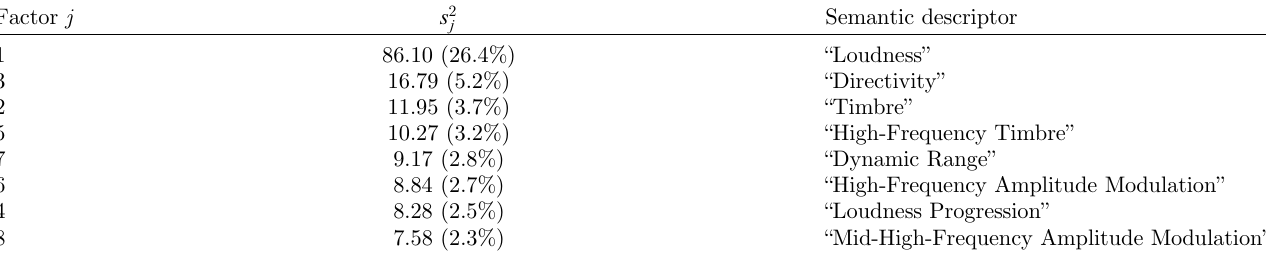
Table 5. Summarized semantic descriptors for the fi rst eight relevant factors. Factor j